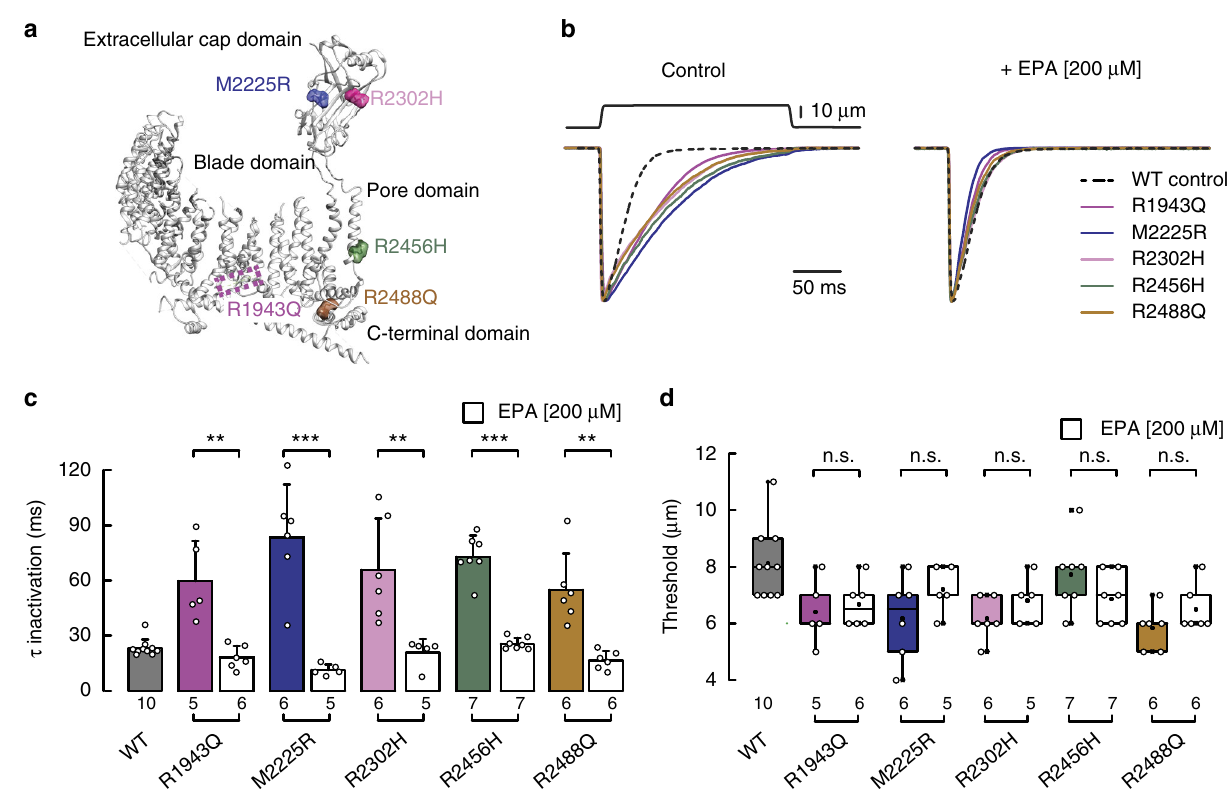
Fig. 7 EPA supplementation abrogates the phenotype of Piezo1 xerocytosis mutations. a Ribbon representation of Mus musculus (mm) Piezo1 monomer (PDB ID: 5Z10) highlighting equivalent residues that when mutated cause dehydrated hereditary stomatocytosis in humans. b Representative normalized macroscopic currents (at − 60 mV) evoked by maximum displacement of N2A cells transfected with human Piezo1 dehydrated hereditary stomatocytosis mutants R1943Q, M2225R, R2302H, R2456, and R2488Q with and without EPA supplementation (left and right, respectively). Human Piezo1 wild type (WT) without supplementation is shown for comparison. c Piezo1 time constants of inactivation elicited by maximum displacement of dehydrated hereditary stomatocytosis mutants R1943Q, M2225R, R2302H, R2456H, and R2488Q with and without EPA supplementation. Human Piezo1 WT without supplementation is shown for comparison. Bars are mean ± SD. Unpaired t -test with Welch correction, except for R2302H in which Mann – Whitney test was used. d Boxplots show the mean, median, and the 75th to 25th percentiles of the displacement threshold required to elicit currents of Piezo1 dehydrated hereditary stomatocytosis mutants R1943Q, M2225R, R2302H, R2456H, and R2488Q with and without EPA supplementation. Human Piezo1 WT without supplementation is shown for comparison. Unpaired t -test, except for R2488Q in which Mann – Whitney test was used. Asterisks indicate values signi fi cantly different from control ( ∗∗∗ p < 0.001 and ∗∗ p < 0.01) and n.s. indicates not signi fi cantly different from the control. n is denoted above the x